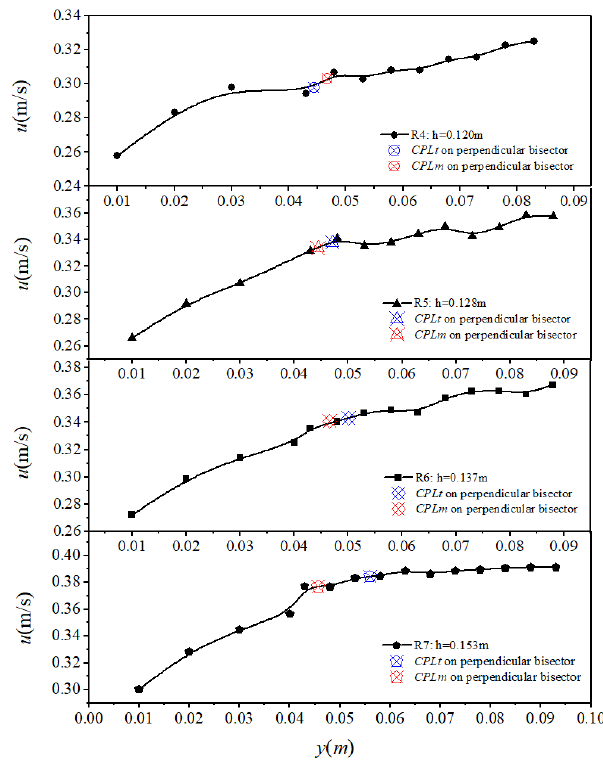
Figure 7. Velocity on the perpendicular bisector with R4-R7 in a rectangular channel.